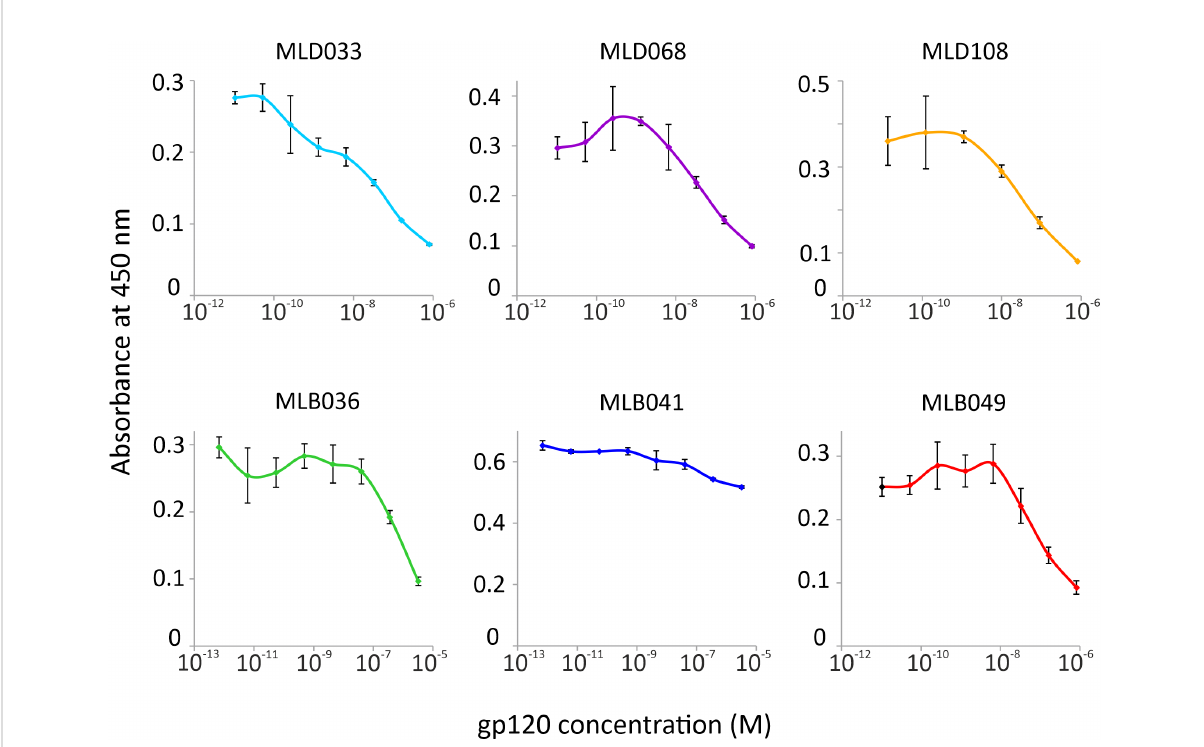
FIGURE 2 Competition of MLD and MLB protein variants with HIV-1 gp120 for binding to PGT121 or PGT126 bNAb in ELISA, respectively. The puri fi ed Myomedin variants MLB036, MLB041, MLD033, MLD108 (His6-Myo-Flag) and in vivo biotinylated variants MLD068 and MLD049 (His6-Myo-Avi) were assayed at a constant concentration 0.5 µM with increasing concentration of gp120, and their binding to PGT121 or PGT126 bNAbs was visualized by the anti-Flag M2 Ab-HRP conjugate or by streptavidin-HRP. Each experiment was performed in triplicates and values are given as an average with standard deviation.